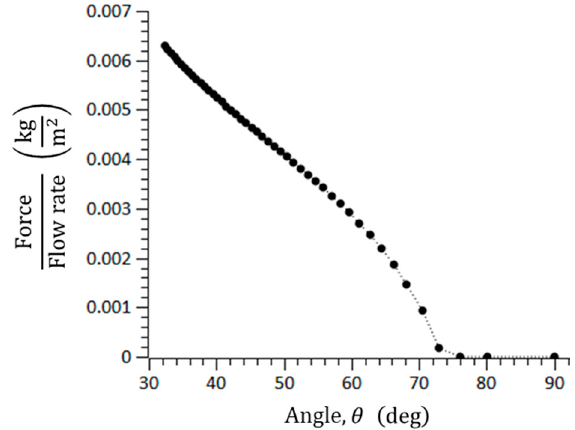
Figure 4. Threshold angle to cause geometrical arching in a rectangular microchannel.